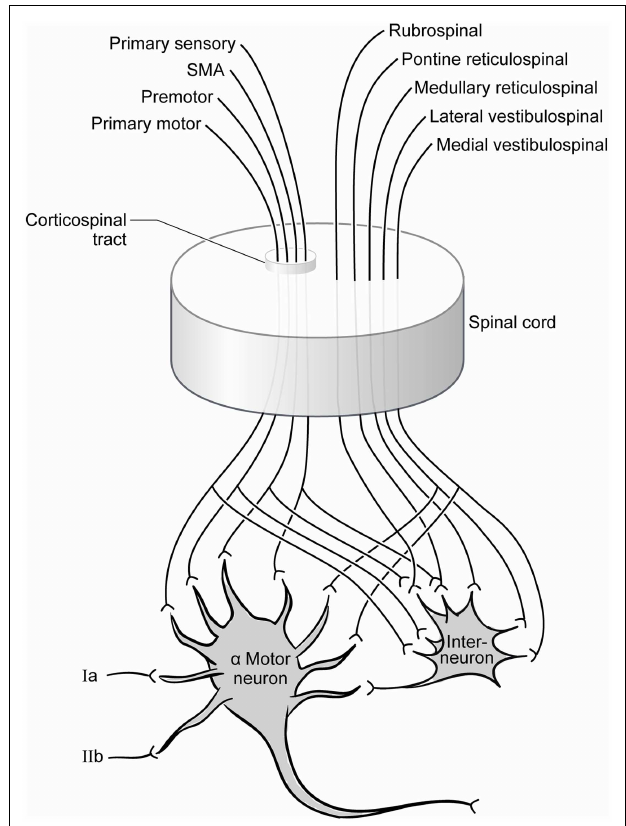
FIGURE 2 | Contemporary summary of the afferent pool of the alpha motor neuron. Significant contributions include those from the spinal interneuron pool whose inputs include the same projections received from the corticospinal